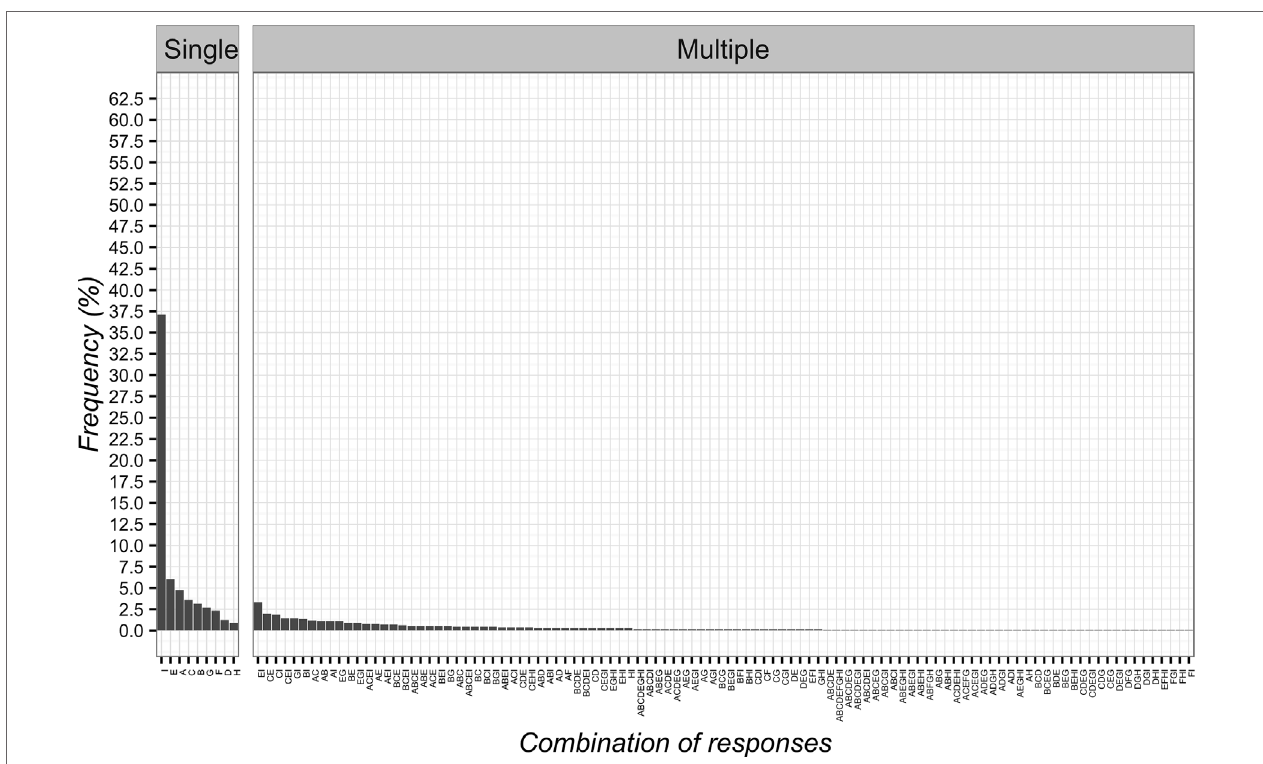
FIGURE 7 | Percentages of responses for Contextual Factors mechanism of action. (A) patient’s expectation; (B) conditioning; (C) suggestibility; (D) natural history of disease; (E) psychological factors; (F) unexplained; (G) physiological/biological factors; (H) spiritual energies; (I) mind–body